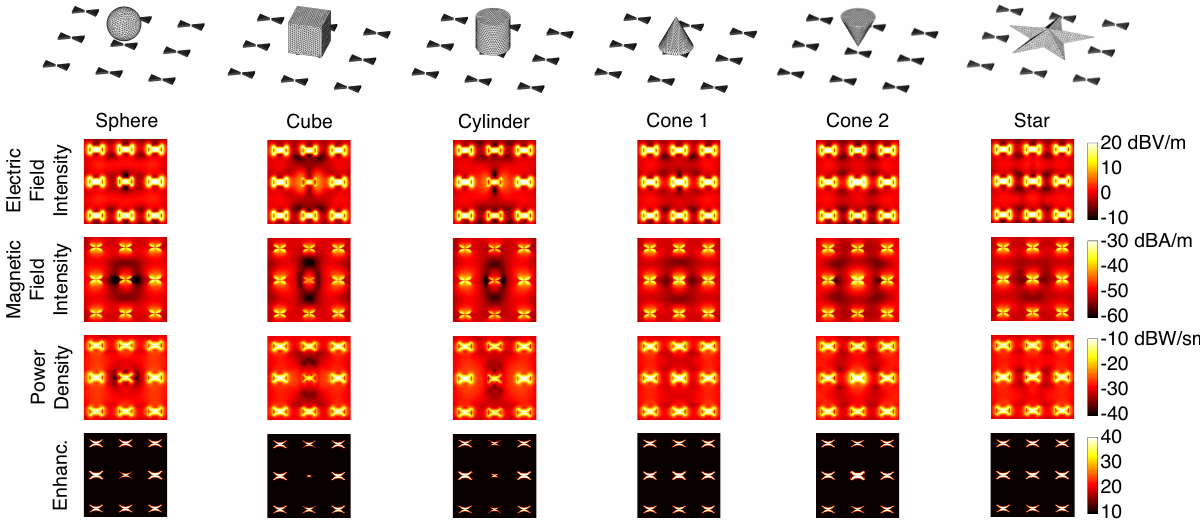
Figure 12: Near-zone characteristics of an array of 3 × 3 nanoantennas when dielectric particles with different shapes are located above the array. The periodicity of the array is 475 nm. The particles are 50 nm away from the top surfaces of the nanoantennas, while their relative permittivity is 8 . 0